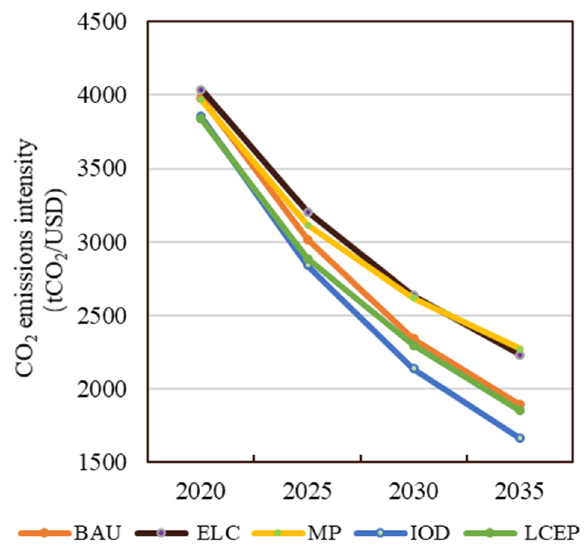
Figure 6. CO 2 emissions intensity forecast for Changxing County.